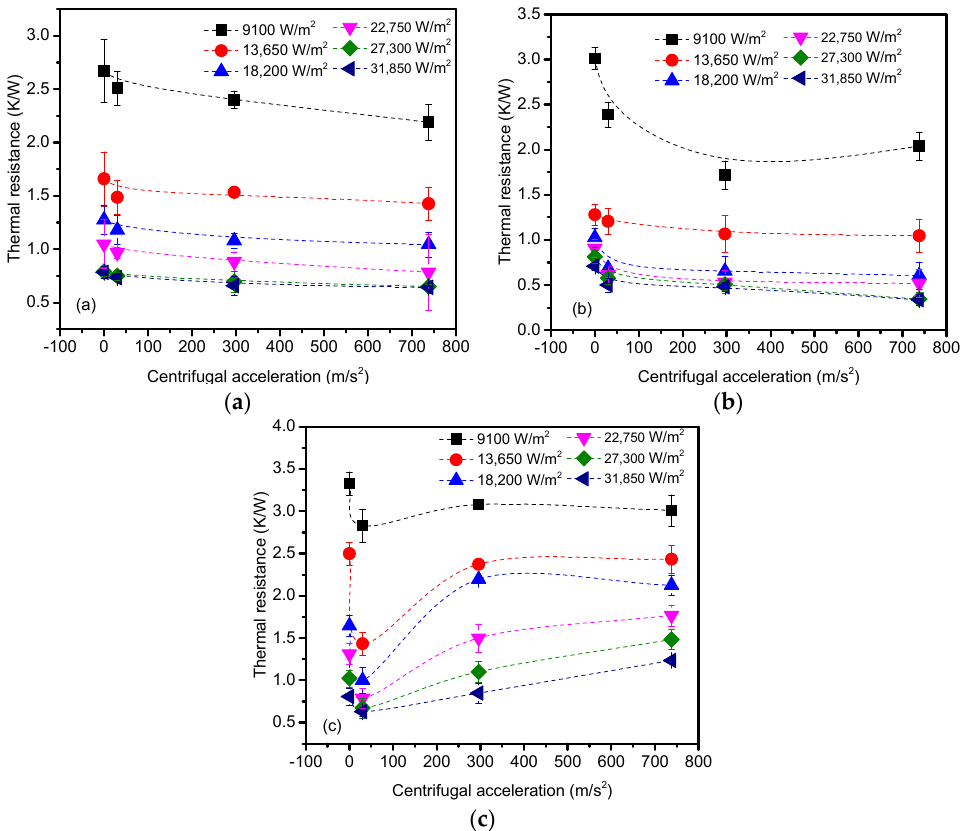
Figure 6. Effects of centrifugal acceleration: ( a ) methanol; ( b ) acetone; and ( c ) DI water.